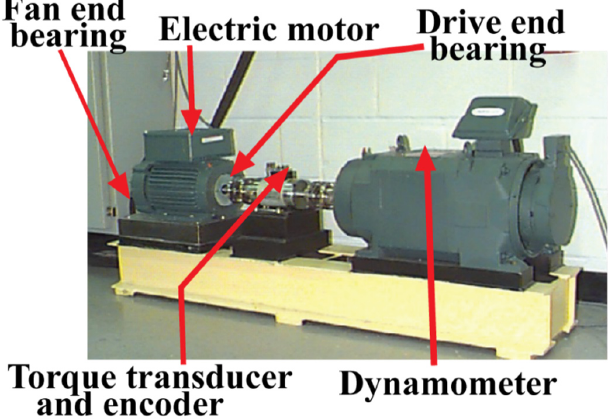
Figure 5. CWRU bearing testbed [46] for collecting vibration signals. Table 2. Details of the dataset collected from the CRWU bearing data bank used in case study